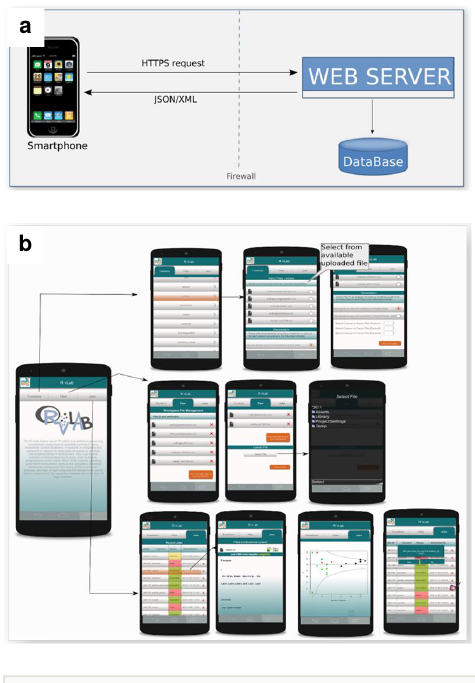
Mobile RvLab application web services and screen shots. a : Data exchange web services between portal and mobile RvLab versions. b : Overall work fl ow of the mobRvLab